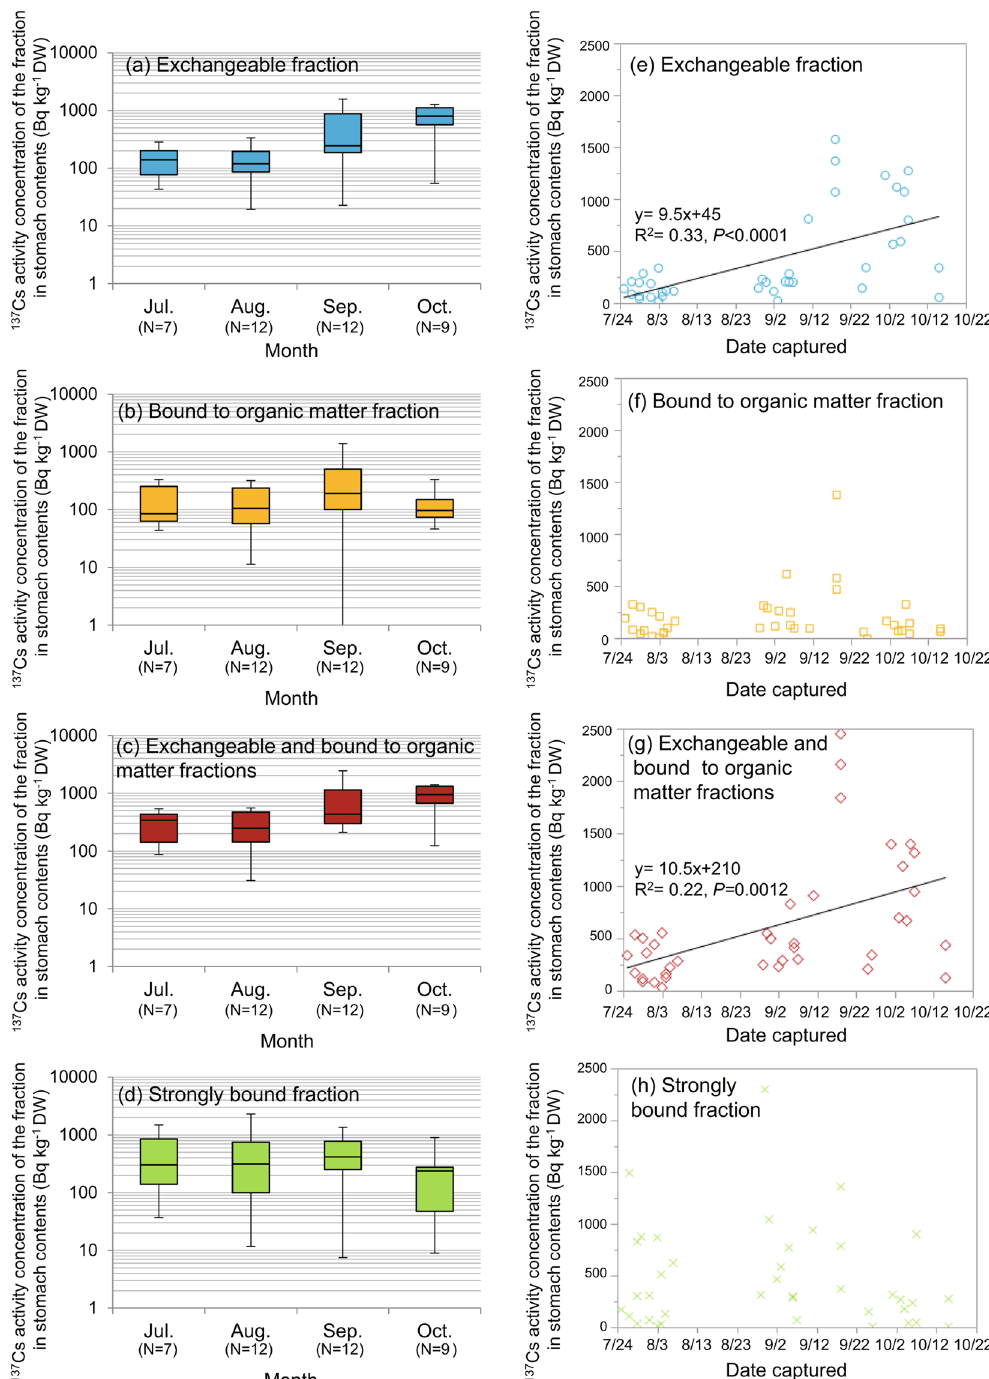
Figure 4. Seasonal variations in the activity concentrations of radiocaesium ( 137 Cs) in different fractions of stomach contents. ( a – d ) Monthly changes in the activity concentrations of 137 Cs in different fractions from July to October in 2015. The upper and lower ends of the box plot indicate the 75th and 25th percentiles, respectively. The horizontal bar in the plot indicates the median value. The whiskers at the upper and lower ends of the box plot indicate the maximum and minimum values, respectively. ( e – h ) Changes in the activity concentration of 137 Cs in different fractions against dates on which animals were captured. The quadratic regression equation and adjusted R-square (R 2 ) are shown only for the cases where a significant difference was observed between the two variables in regression analysis. DW: Dry